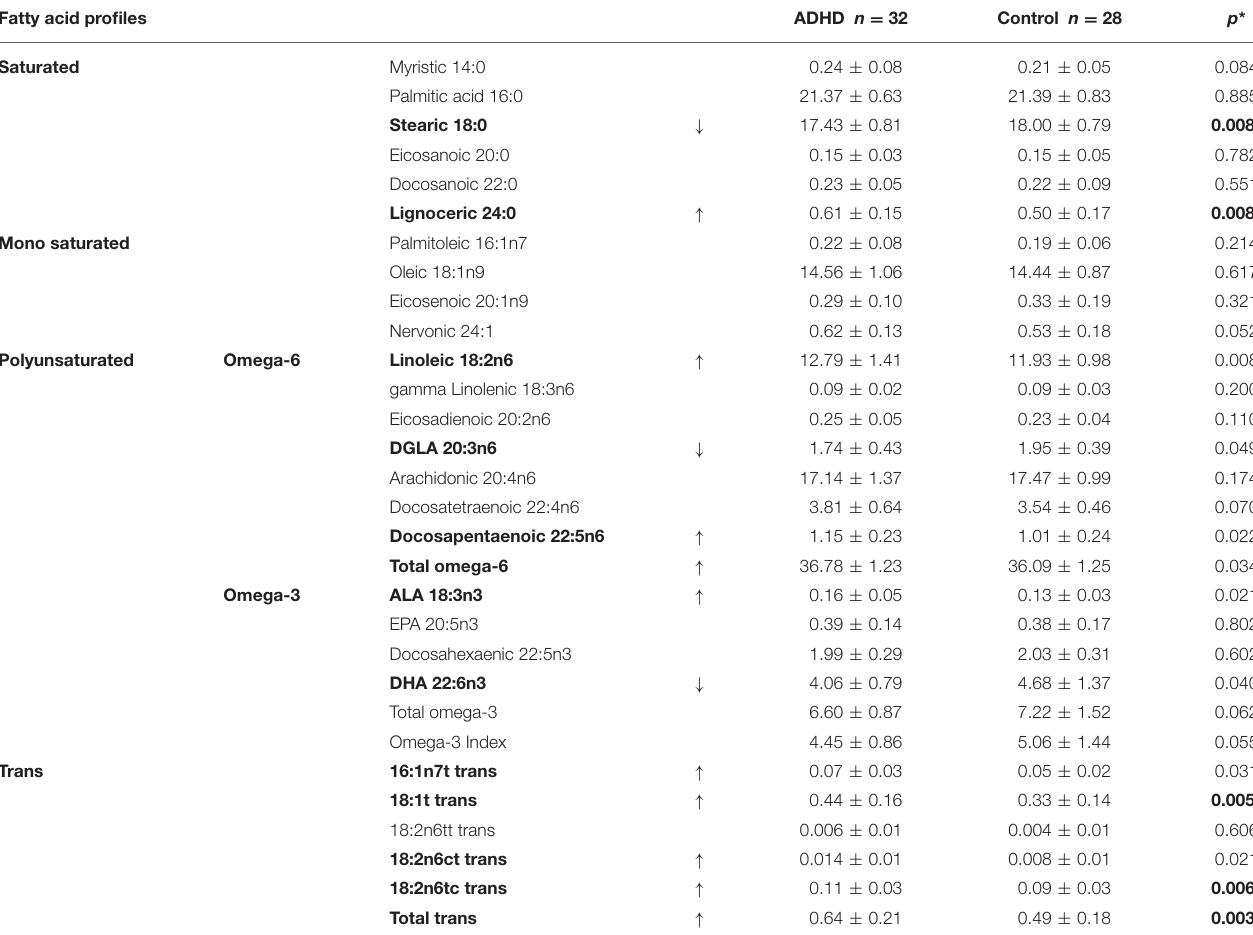
TABLE 3 | Fatty acid profiles from RBC membranes comparing children with ADHD vs. without (control). Fatty acid profiles ADHD n = 32